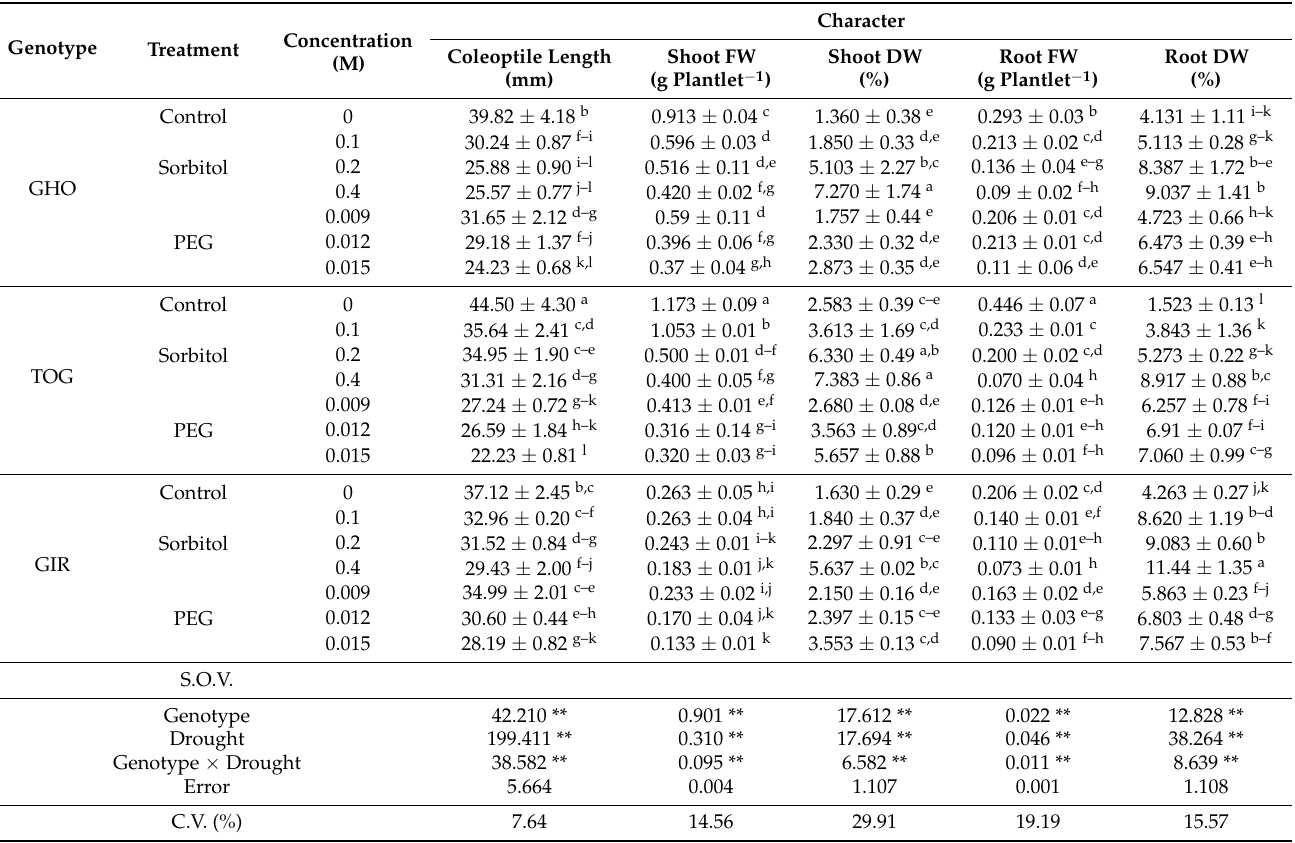
Table 1. Effect of sorbitol and PEG-induced drought stress on morphological traits of three melon genotypes under in vitro culture